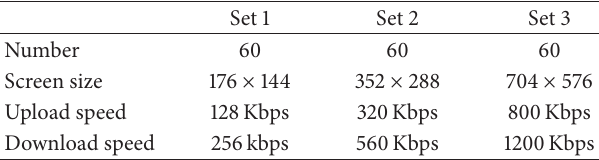
Table 6: Quality adaptation with the LLA compared to the